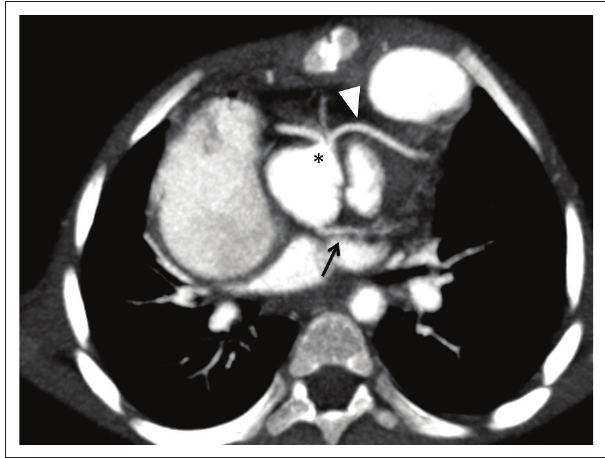
FIGURE 9: Conjoined anomalous origin of the coronary arteries in a 33-month- old girl. Thin-section axial CT shows the common origin of the LAD (white arrowhead) arising in conjunction with the RCA from the right coronary sinus (asterisk). The left circumflex coronary artery takes normal origin from the left coronary sinus (black arrow).